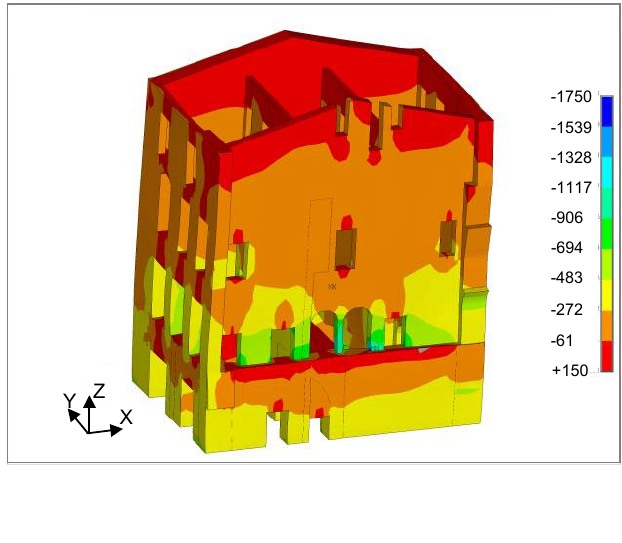
Figure 9. Static analysis: vertical compressive stresses, detail of the internal wall (units are kN/m 2